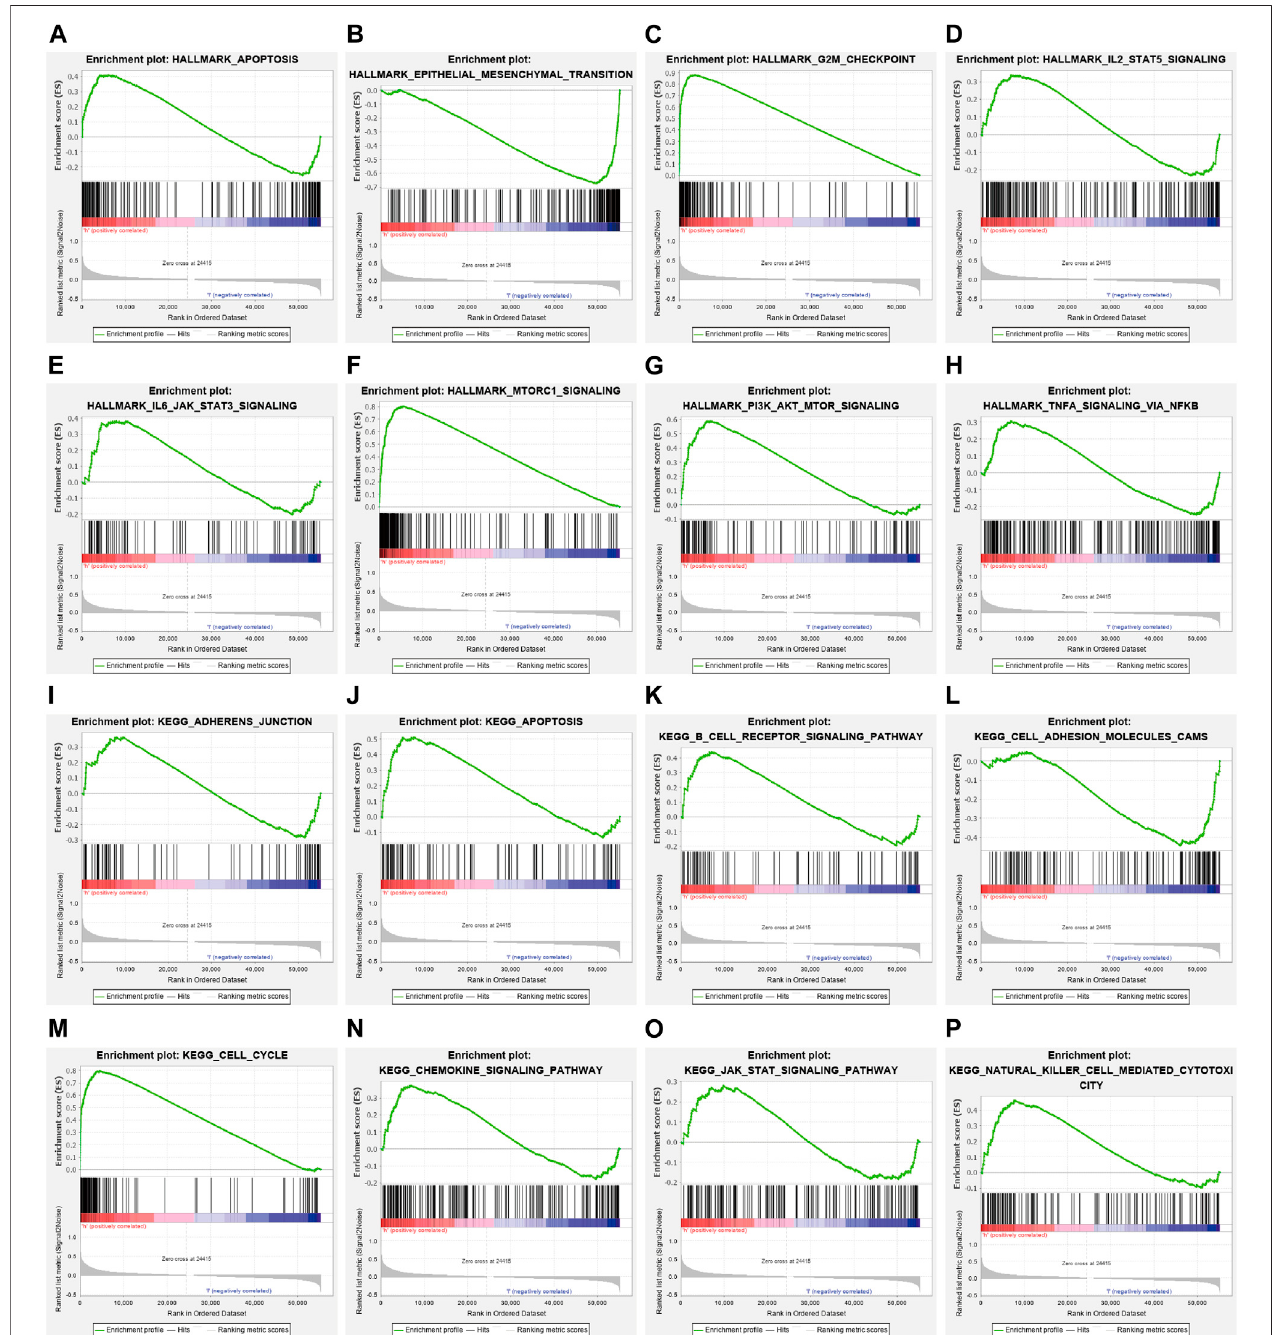
FIGURE 6 | The signaling pathway for NCAPG enrichment by GSEA software. (A – P) The signaling pathway for NCAPG enrichment by GSEA software.